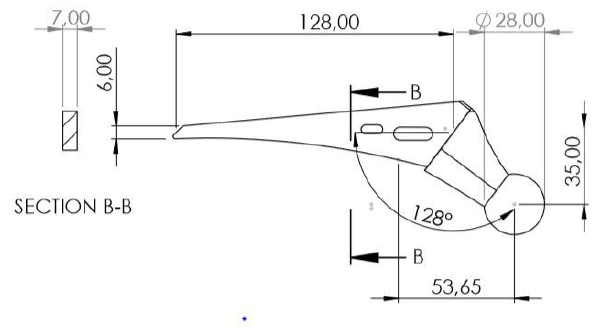
Figure 2: Main size of hip stem with stem length 128